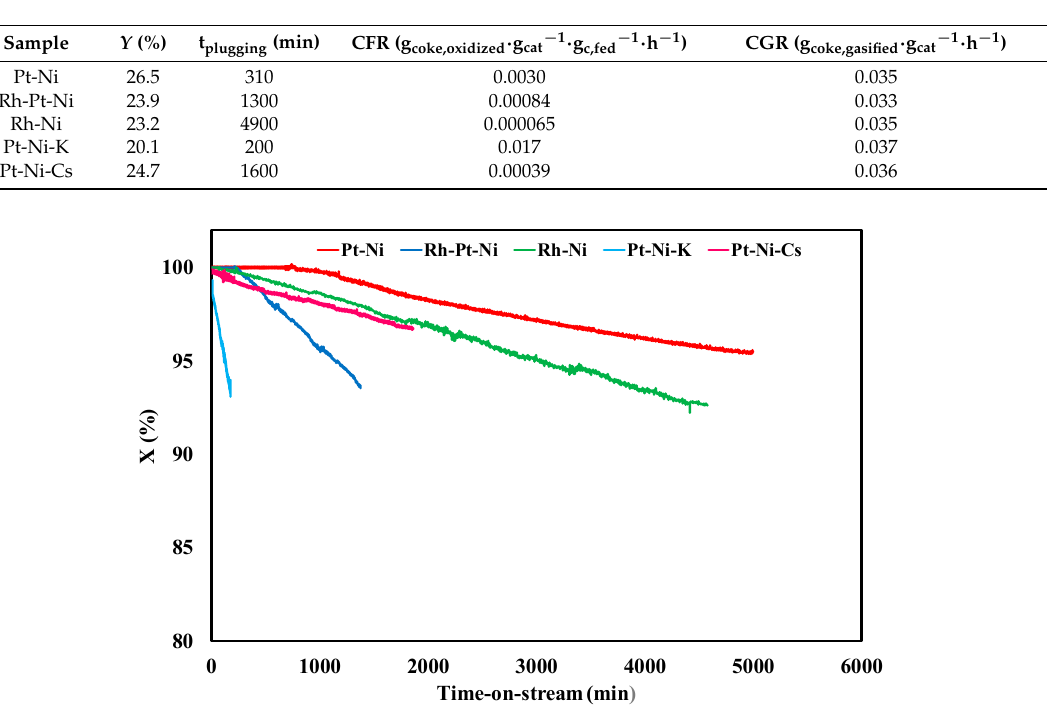
Figure 3. Results of stability tests on CeO 2 -SiO 2 based catalysts at 450 °C, f.r. = 3 and WHSV = 4.1 h − 1 .